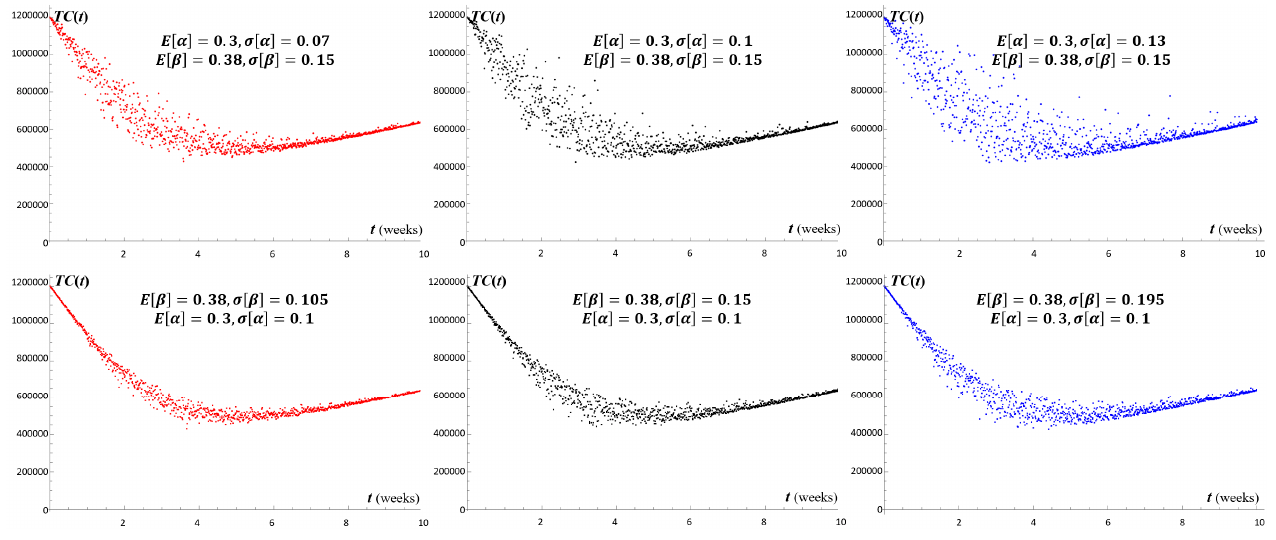
Figure 11. Scatter plots of 𝑇𝐶(𝑇) under different standard deviations 𝛼 and 𝛽 .